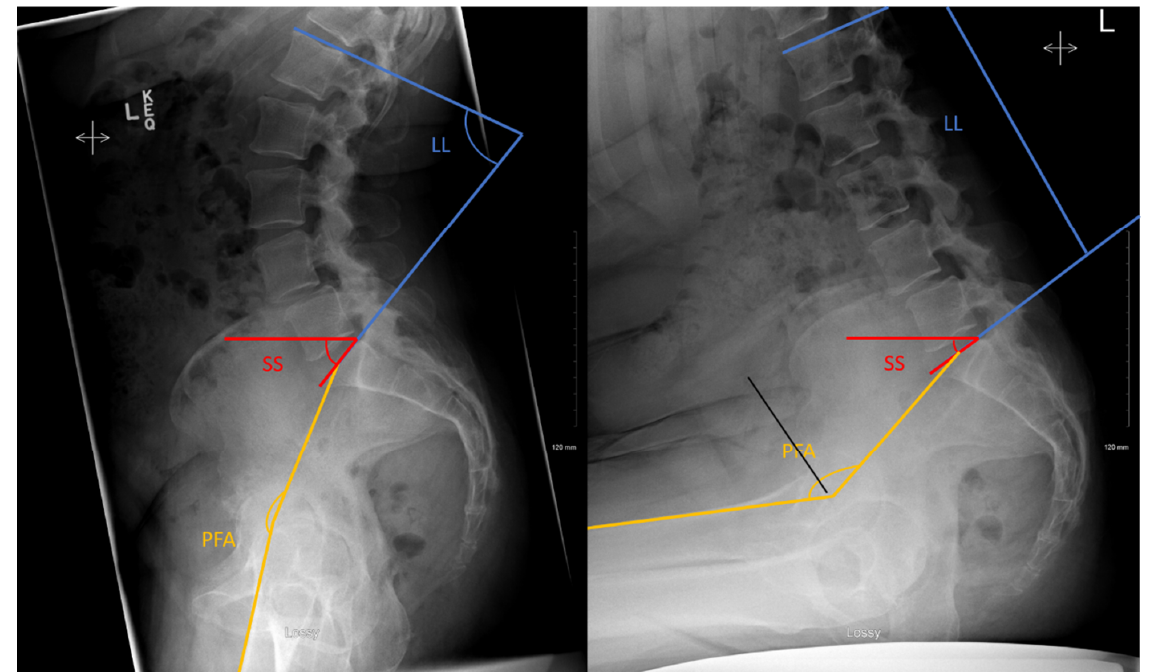
Figure 1. Lateral view of the lumbar spine and pelvis from the standing ( left ) and seated deep flexed forward ( right ). With angles calculated for sacral slope (SS), which is the angle tangent to the S1 endplate and a transverse line; pelvic femoral angle (PFA) defined as an angle based on a line from the center of the S1 endplate to the center of the femoral head and a second line that parallels the diaphysis of the femur; lumbar lordosis (LL) being a line tangent to the S1 endplate relative to a line tangent to the superior L1 endplate. The changes in SS were considered equivalent to the changes in pelvic tilt (PT).